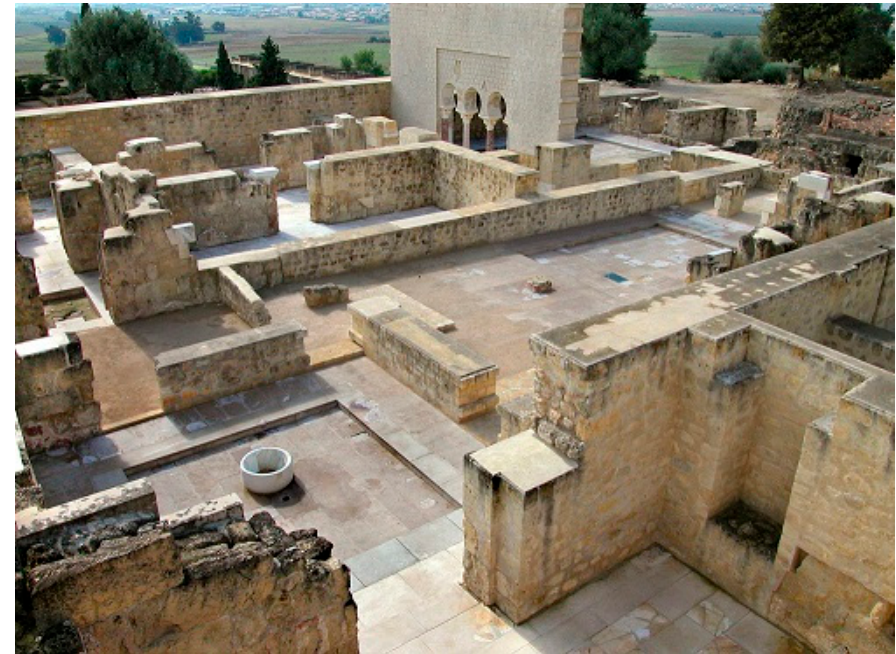
Figure 12. House of Ja c far. Private and service areas (Photo M. Pijuán © Conjunto Arqueológico de Madinat al-Zahra).